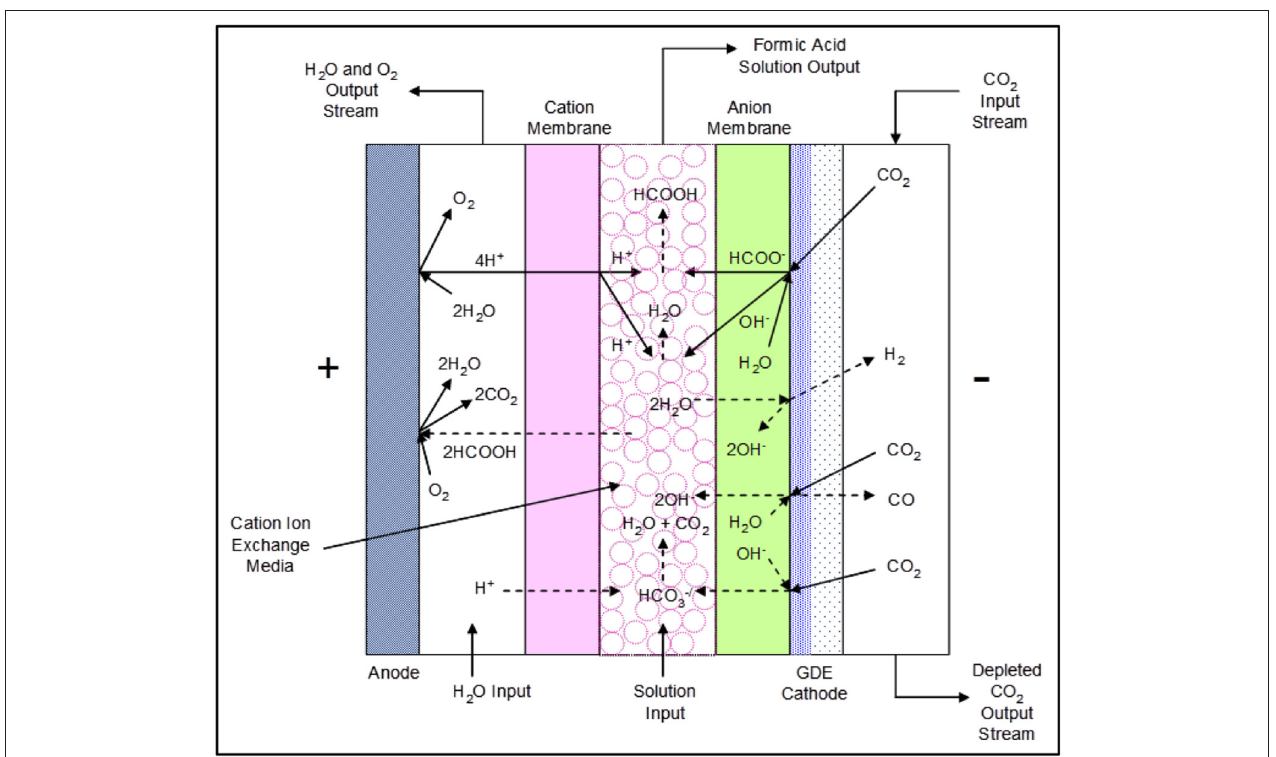
FIGURE 3 | The DM 3-compartment formic acid cell configuration showing proposed reactions and ion transport.